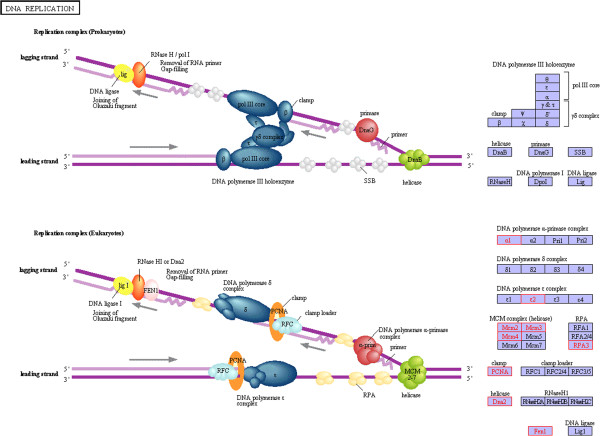
DNA replication pathway. The red stars indicate the up-regulated genes of mesenchymal stem cells from primary osteoporosis tissues in this pathway.